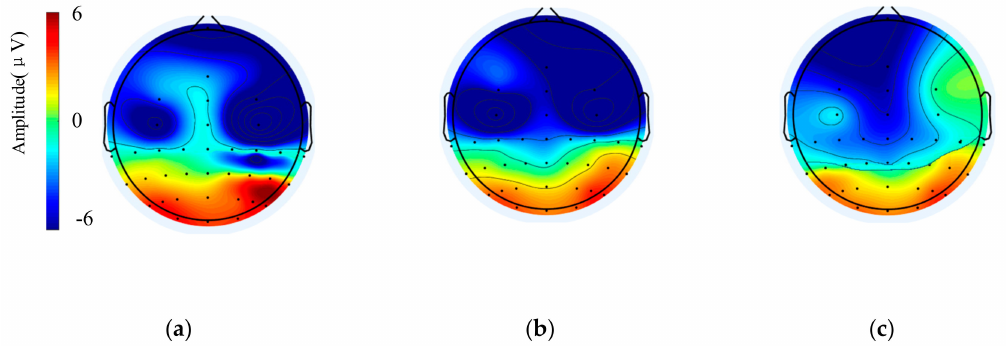
Figure 5. The topographic map of the brain under di ff erent mental workloads: ( a ) 250 ms after stimulation under LD; ( b ) 250 ms after stimulation under MD; ( c ) 250 ms after stimulation under